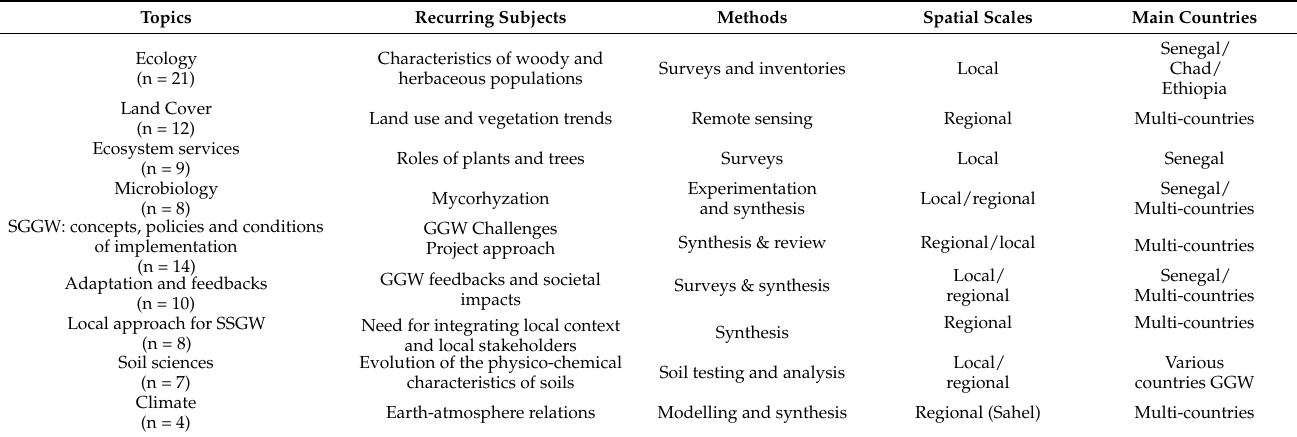
Table 1. The main topics of SGGW research and the methodologies, spatial scales and main countries associated with these studies collected by the keyword GGW in WoS, Science Direct, HAL, Horizon and Agritrop databases (n =